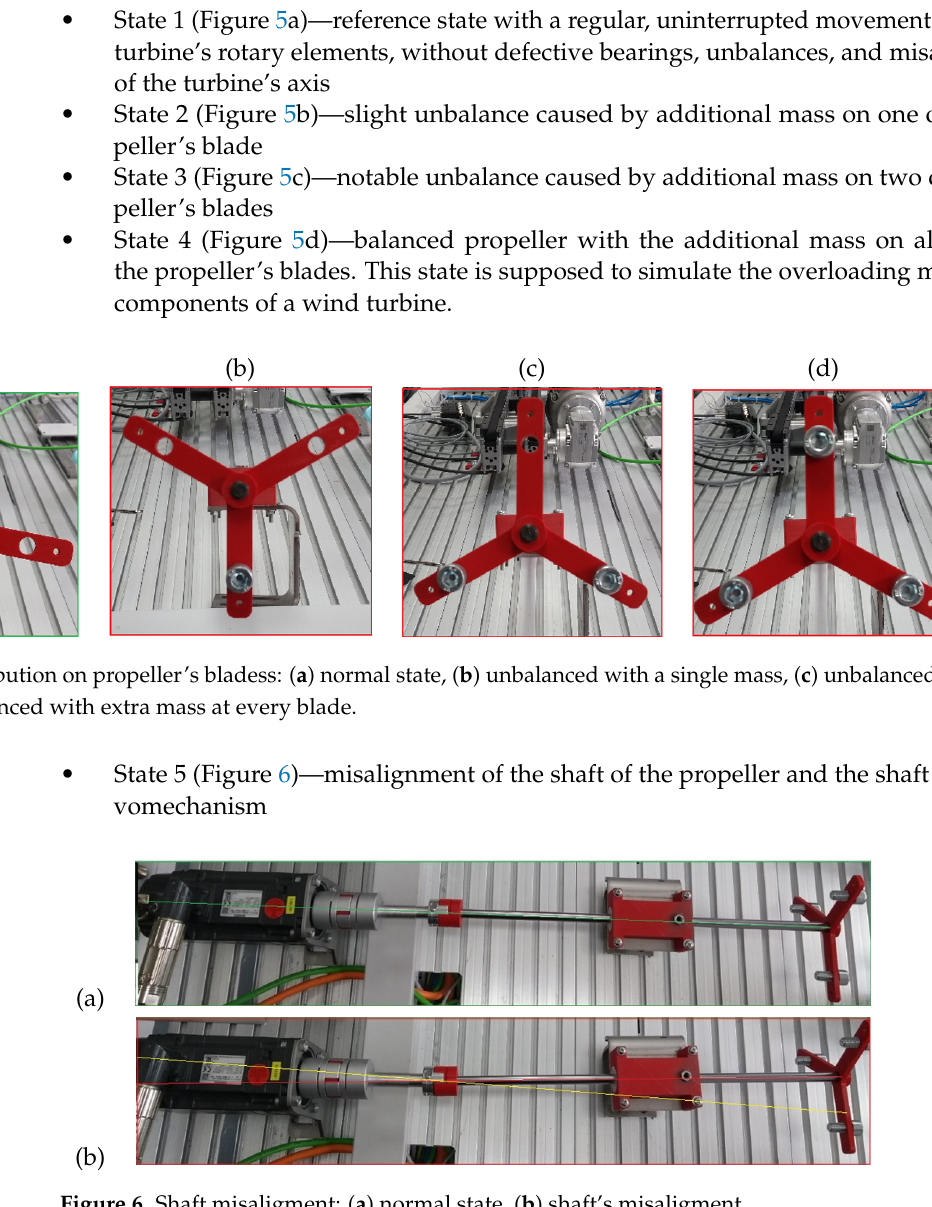
Figure 6. Shaft misaligment: ( a ) normal state, ( b ) shaft’s misaligment.